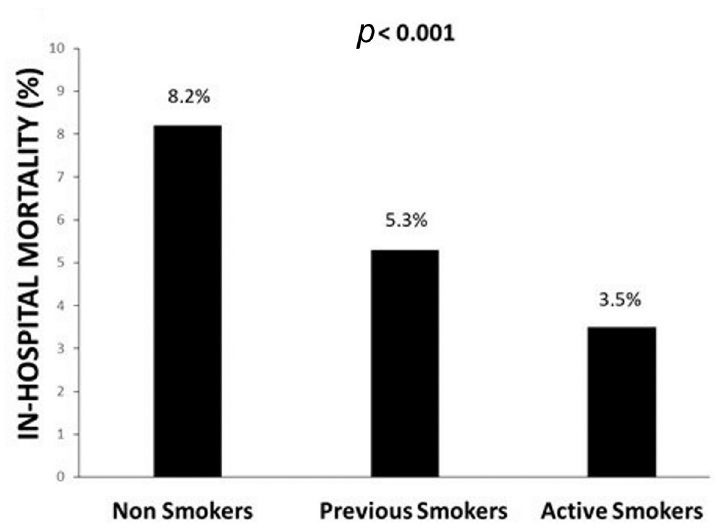
Figure 2. Bar graphs show the association between smoking status and in-hospital mortality.